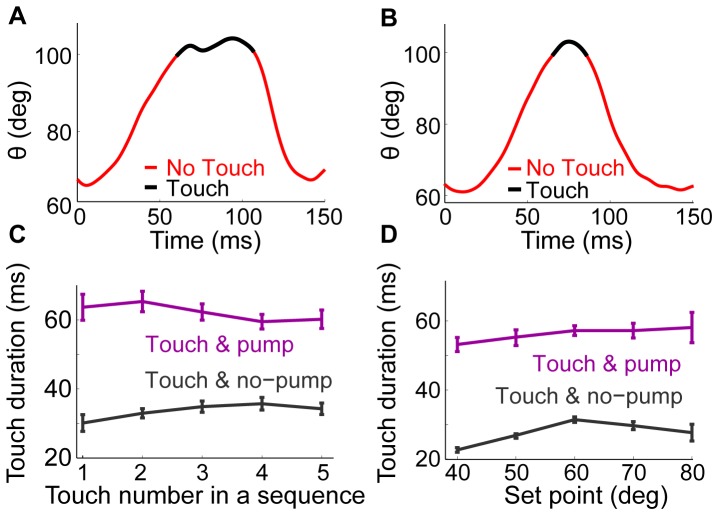
Contact durations are longer in whisks with TIP.
A. A typical single whisk with a pump after touch onset. Period of whisker-pole contact marked in black. The pump occurred while the whisker stayed in contact with the pole. B. A typical single whisk without a pump after touch onset. C. Touch duration as a function of the position of the touch in a sequence of touches. Whisks with touch and TIP (purple) and whisks with touch but no TIP (gray). D. Touch duration with and without a TIP, as a function of the set point.